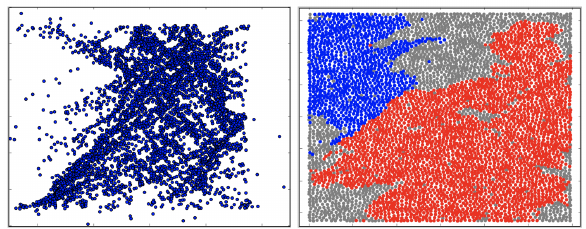
Figure 4. Pre-failure regime. Scatter plot of displacements in DSS at the axial strain interval of [0.0008,0.0012] (left). Member nodes of the di ff erent components in G ( r ) just before percolation transition S ( r max( γ ) − δ ), mapped back into the physical domain of the sample: members of the largest and second largest connected components are colored red and blue, respectively, with the rest in grey